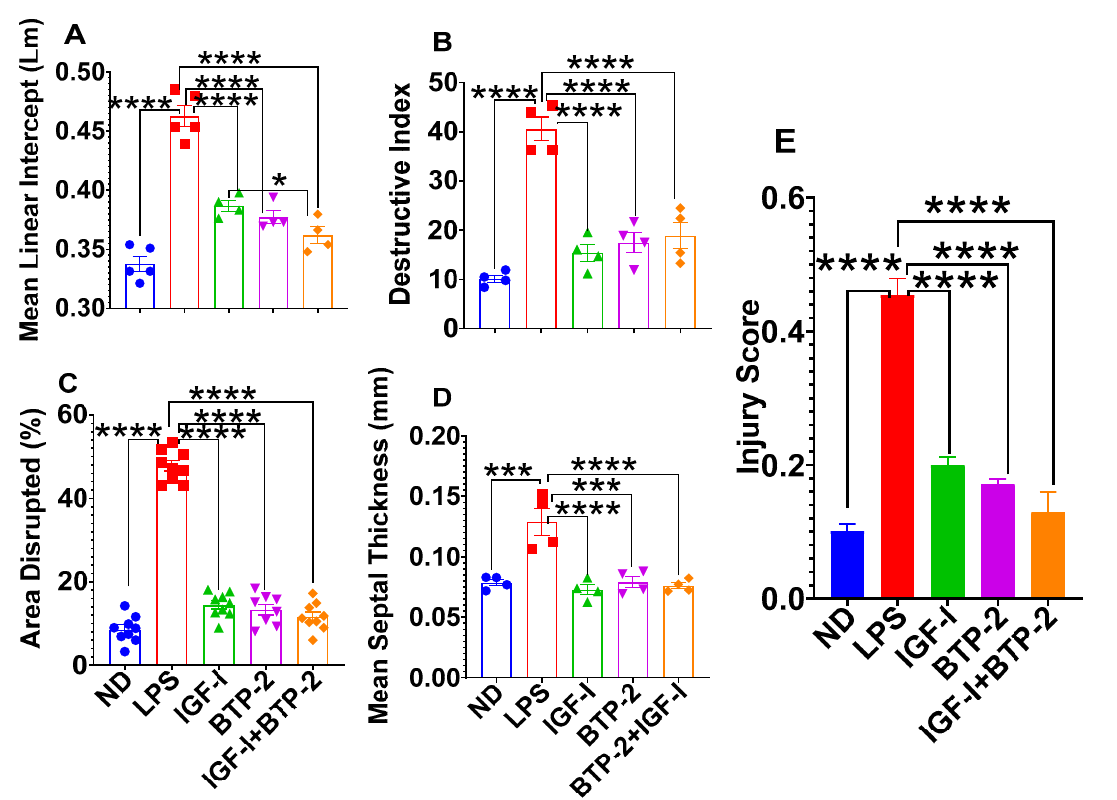
Figure 7. Effects of the IGF—I and BTP—2 monotherapies and the IGF—I + BTP—2 combination therapy on the tissue structures in the lungs. The histomorphometry parameters ( A ) Mean linear intercept, ( B ) destructive index, ( C ) percentage of the area disrupted, ( D ) mean septal thickness, and ( E ) the injury score were quantified by the evaluation on Day 7 of the lung sections stained by H&E. The histology quantification data are the mean ± SEM. * p < 0.05, *** p < 0.001, and **** p < 0.0001. One—way ANOVA, followed by Dunnett’s multiple comparisons